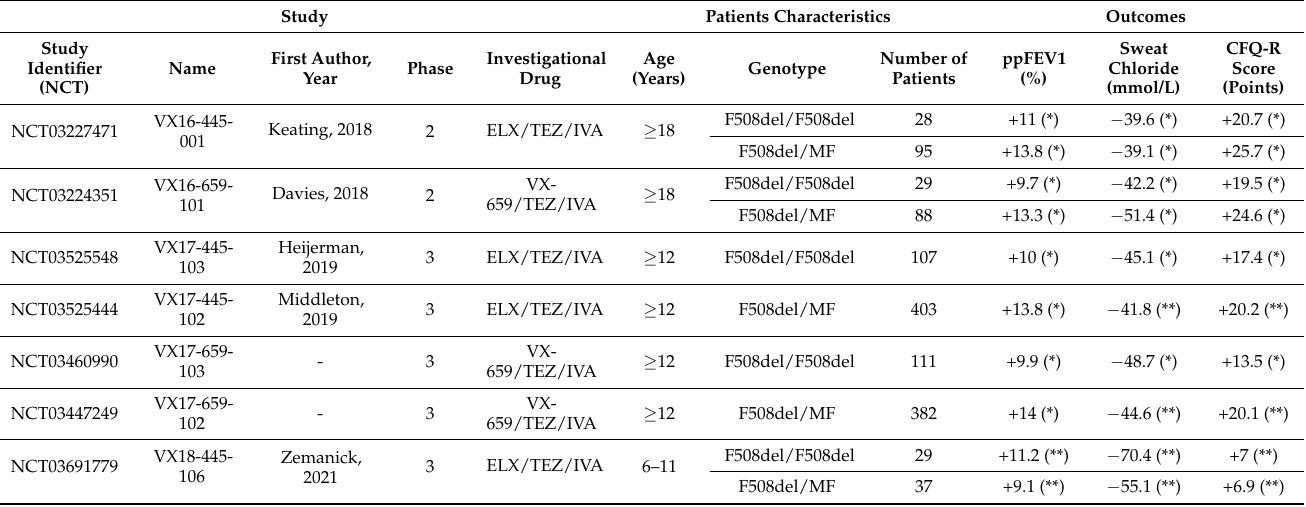
Table 2. Summary of clinical trials on CFTR -modulators triple therapy. Abbreviations: F/F = F508del/F508del genotype, F/MF = F508del/MF